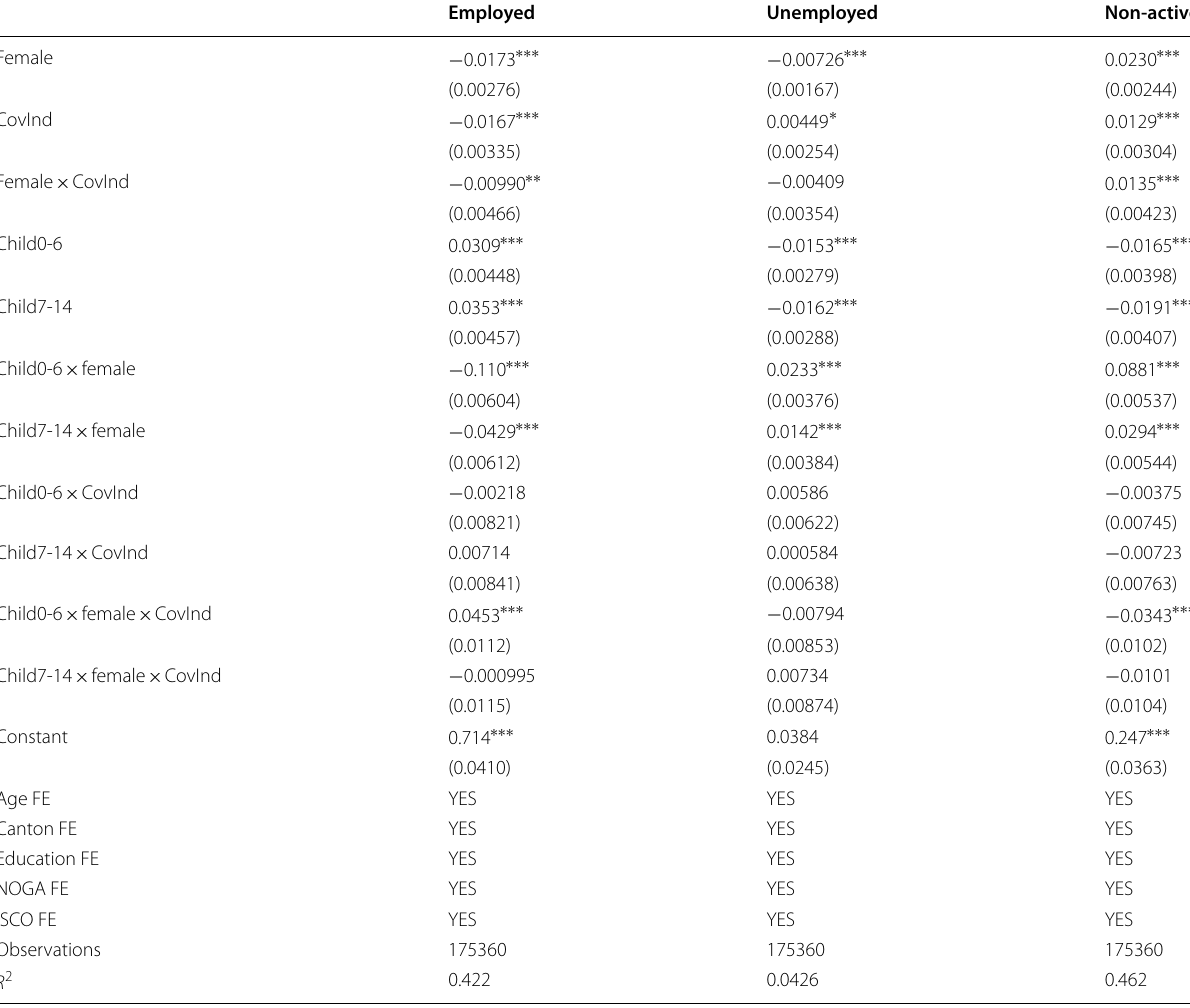
Table 4 COVID-19, labor market status, and child care